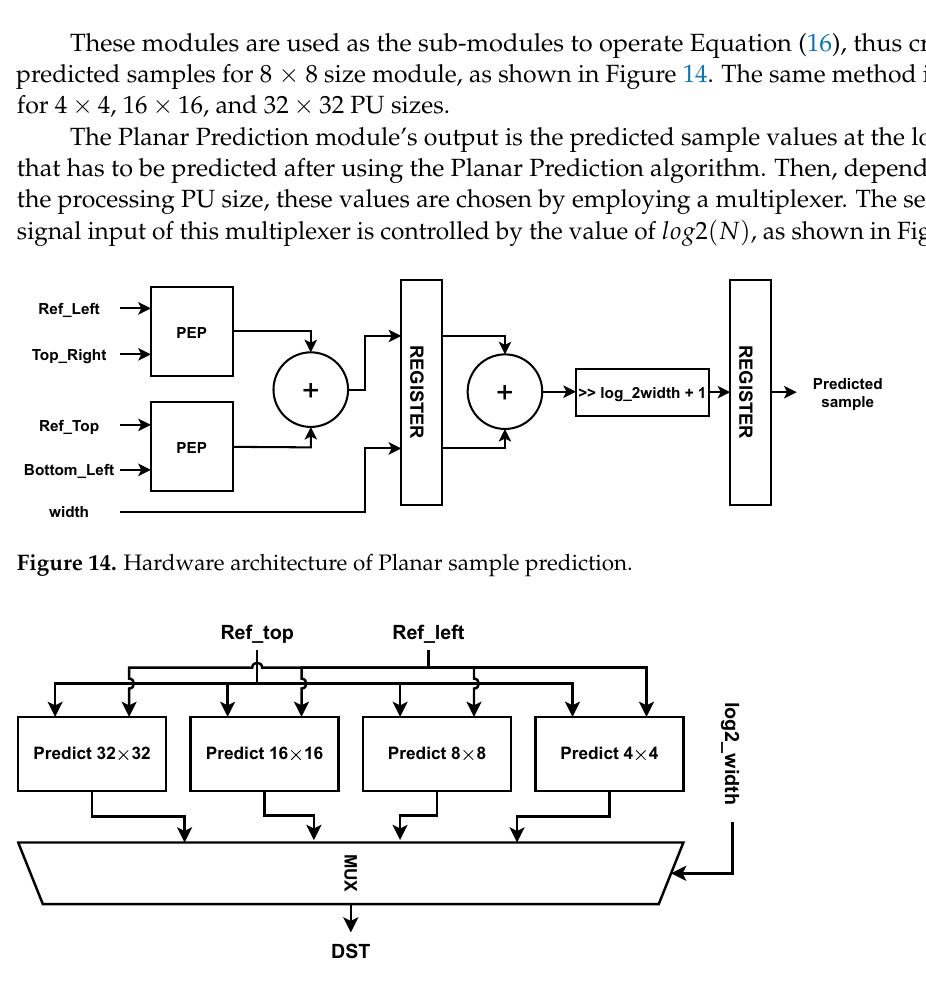
Figure 15. Hardware architecture planar